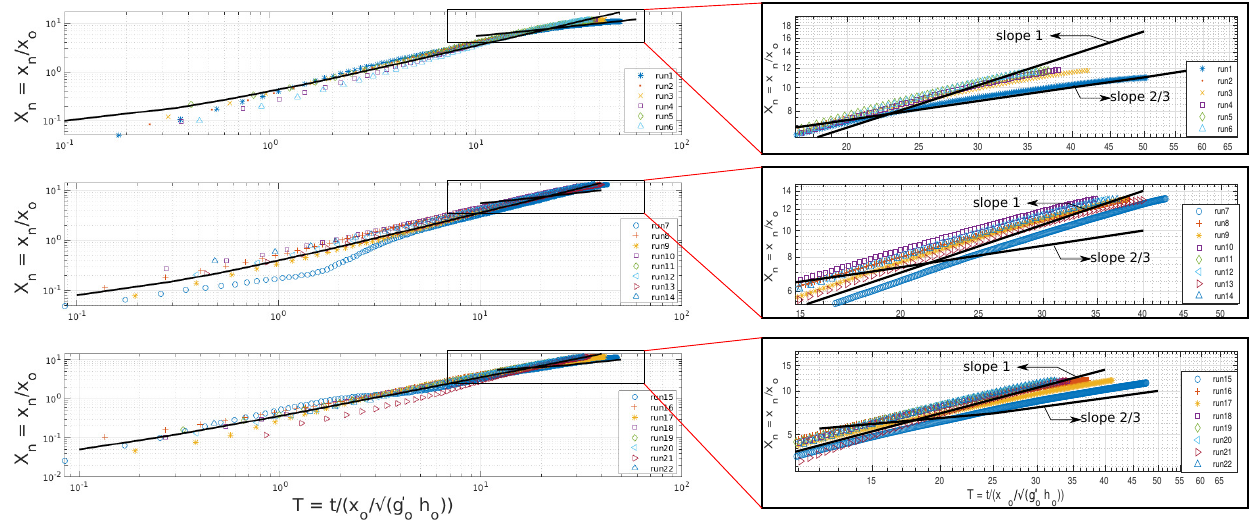
Figure 8. Log-Log plot of dimensionless time, T, vs. dimensionless front positions for all experimental runs. The solid lines represent the slopes 1 and 2/3 for the long and short lines, respectively. The right figure provides a more detailed look at the transition point of the current from slope 1 to slope